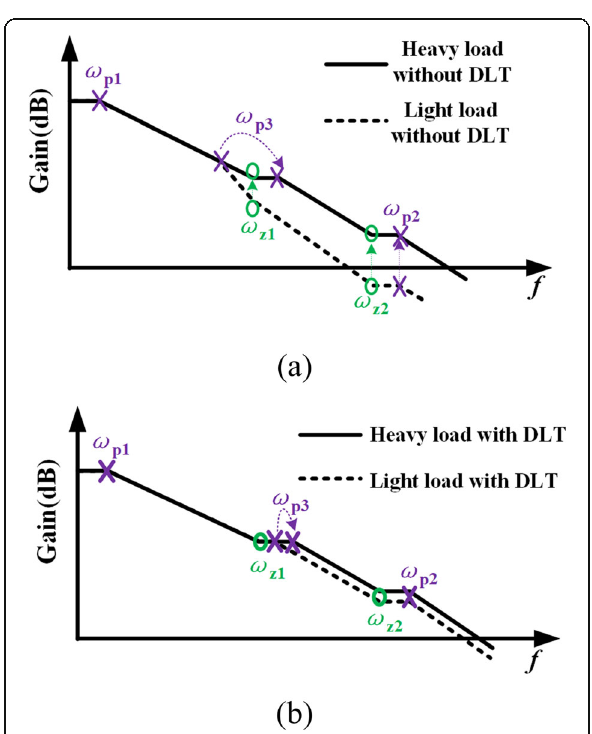
Fig. 6 Frequency response of voltage regulator. a Voltage regulator without dynamic load technique. b The proposed voltage regulator with dynamic load